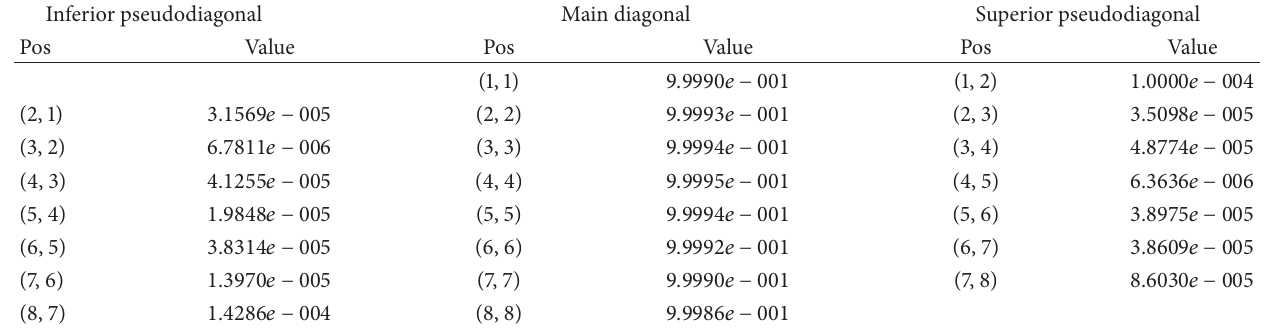
Table 1: Nonnull elements of the input traffic transition probability matrix.